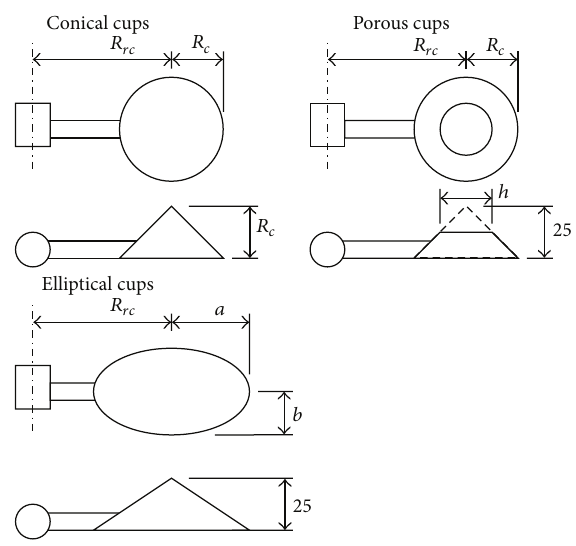
Figure 2: Sketch of the cups and rotor geometries tested. Dimen- sions in mm. See also Table